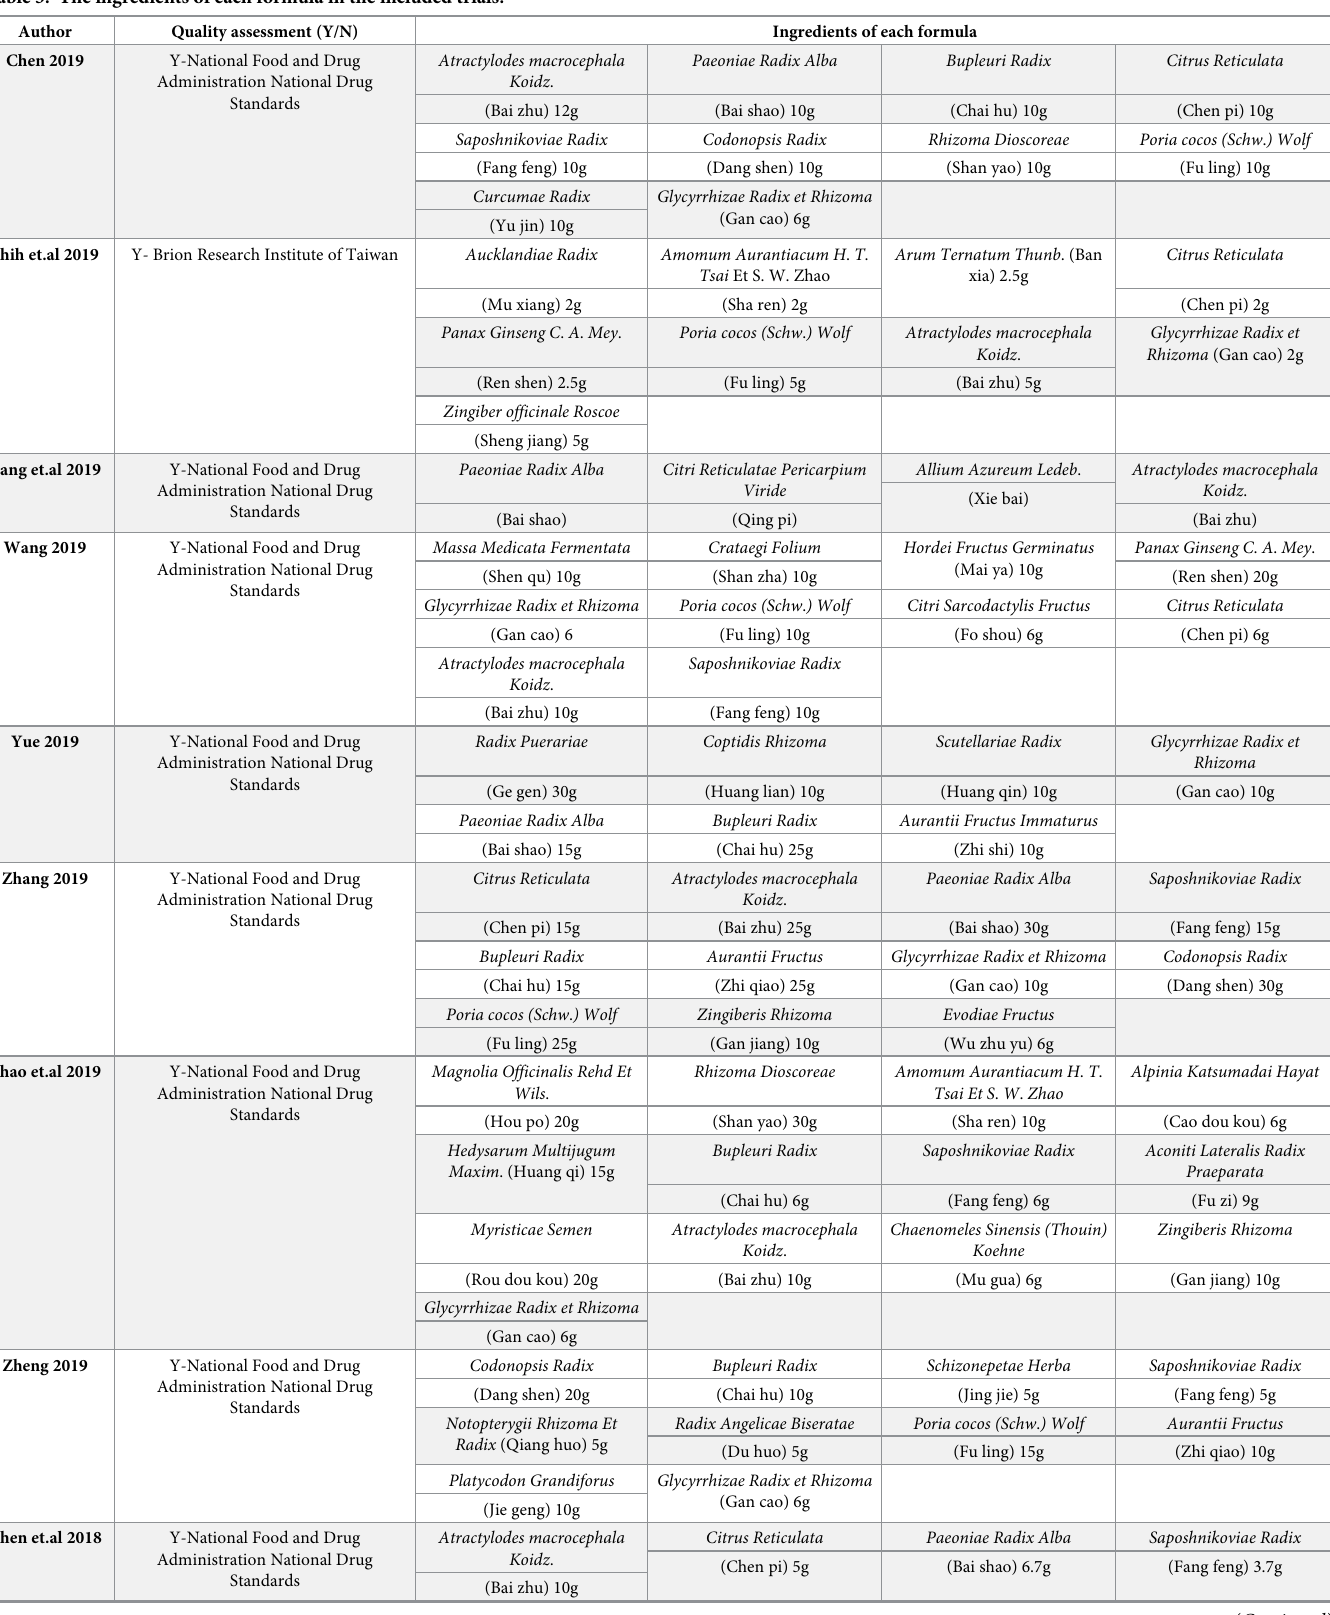
Table 3. The ingredients of each formula in the included